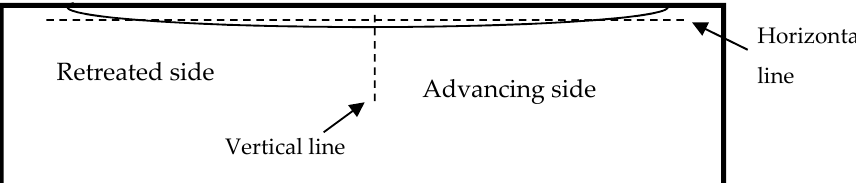
Figure 3. Schematic illustration of the microhardness measurements vertical and horizontal lines.